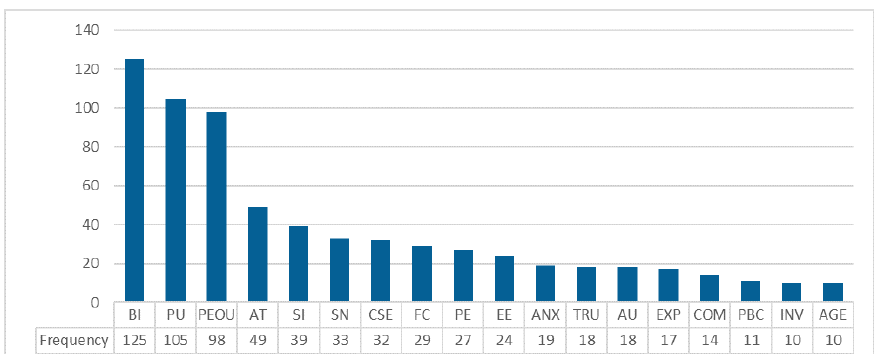
Figure 3. Key factors affecting technology acceptance in healthcare.